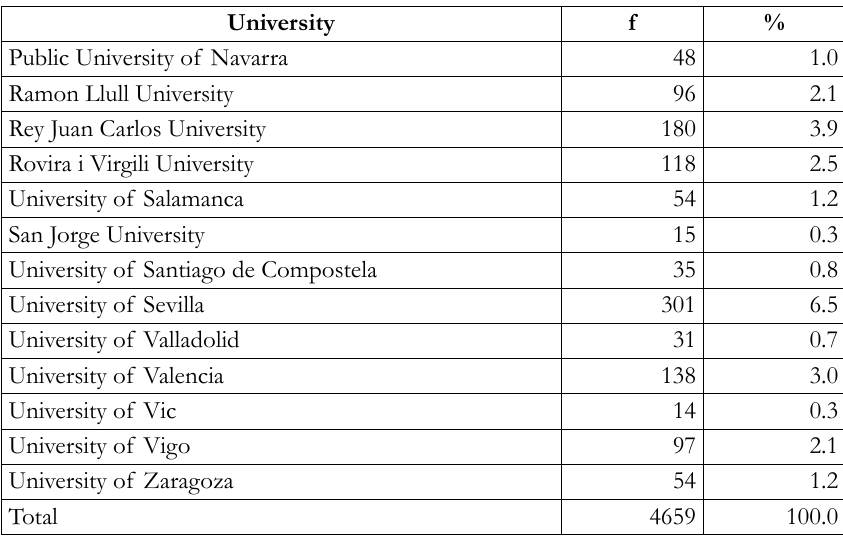
Table 1. Sample participants according to university (Lorenzo-Lledó,